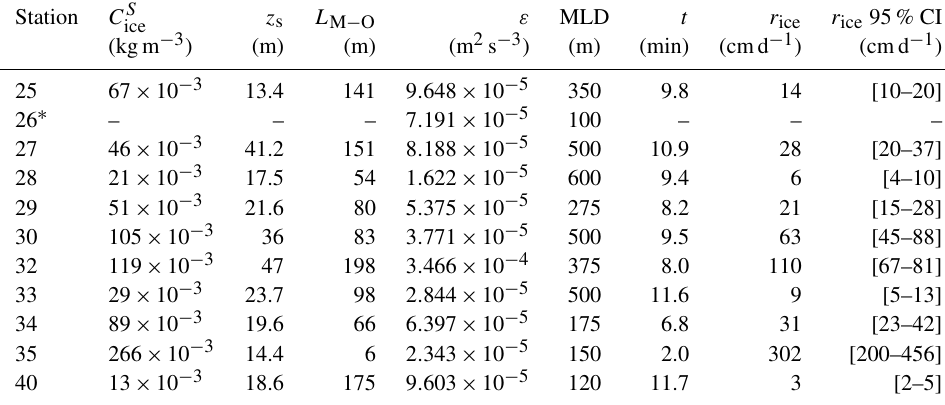
Table 2. Summary of mass of ice derived from salinity, lifetime, and production rates. Station